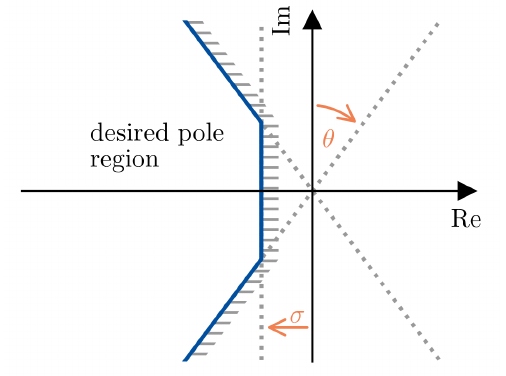
Figure 11. Desired area for pole locations in the complex